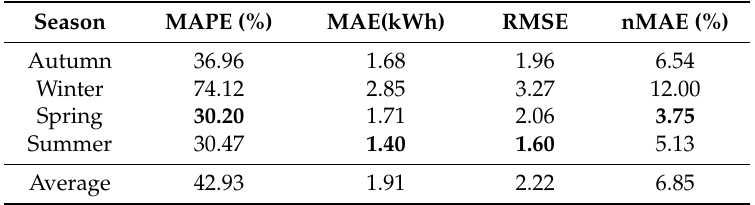
Table 3. Seasonal Performance of PV power